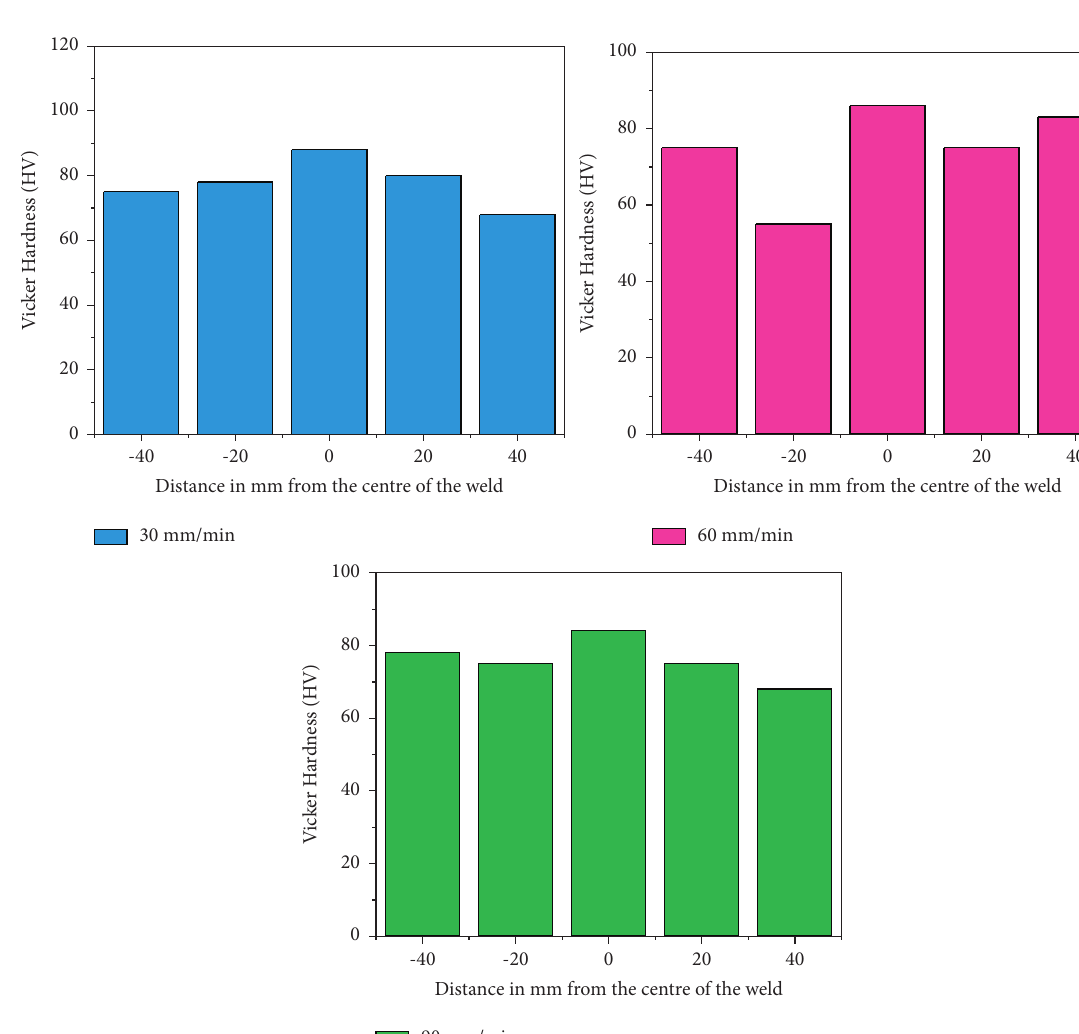
Figure 7: Vickers hardness value for the threaded cylindrical